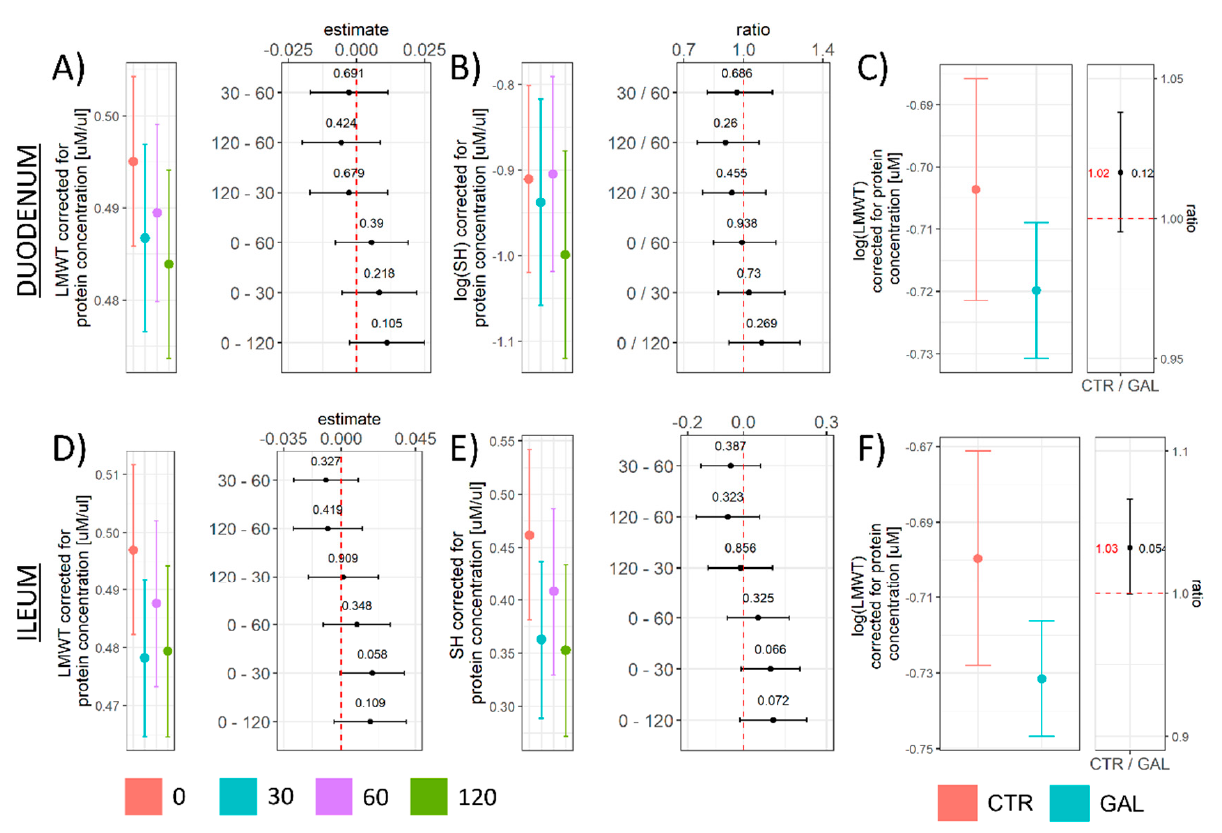
Figure 2. The concentration of LMWT and tissue protein SH content in the rat duodenum and ileum following acute orogastric gavage of 200 mg/kg D -galactose. ( A ) Duodenum LMWT model output (group point estimates with 95% confidence intervals) ( left ) and the differences of estimated marginal means for groups with corresponding 95% confidence intervals ( right ). ( B ) Duodenum protein SH model output (group point estimates with 95% confidence intervals) ( left ) and ratios of estimated marginal means for groups with corresponding 95% confidence intervals ( right ). ( C ) Duodenum log(LMWT) pooled treatment effect model output (group point estimates with 95% confidence intervals) ( left ) and ratios of estimated marginal means for treatments with corresponding 95% confidence intervals ( right ). ( D ) Ileum LMWT model output (group point estimates with 95% confidence intervals) ( left ) and the differences of estimated marginal means for groups with corresponding 95% confidence intervals ( right ). ( E ) Ileum protein SH model output (group point estimates with 95% confidence intervals) ( left ) and the differences of estimated marginal means for groups with corresponding 95% confidence intervals ( right ). ( F ) Ileum log(LMWT) pooled treatment effect model output (group point estimates with 95% confidence intervals) ( left ) and ratios of estimated marginal means for treatments with corresponding 95% confidence intervals ( right ). LMWT—low-molecular-weight thiols; SH—protein sulfhydryl content. Raw p -values (black) and raw values (red) are reported alongside point estimates. 0—Baseline control; 30—group sacrificed 30 min after galactose treatment; 60—group sacrificed 60 min after galactose treatment; 120—group sacrificed 120 min after galactose treatment. CTR—Control animals; GAL—animals treated with galactose.